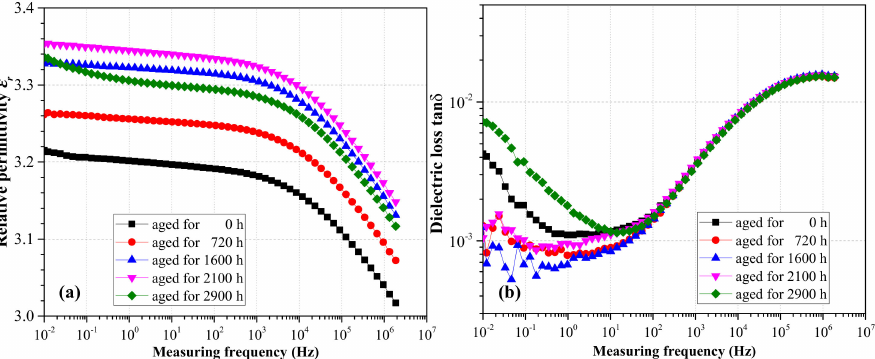
Figure 3. ( a ) Relative permittivity ε r and ( b ) dielectric loss tan δ of thermally aged PET films aged at 110 ◦ C.